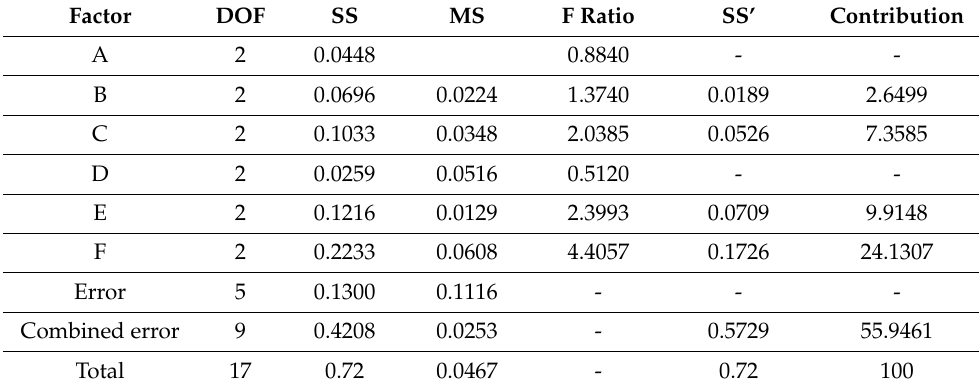
Table 9. The ANOVA of the tensile strength.